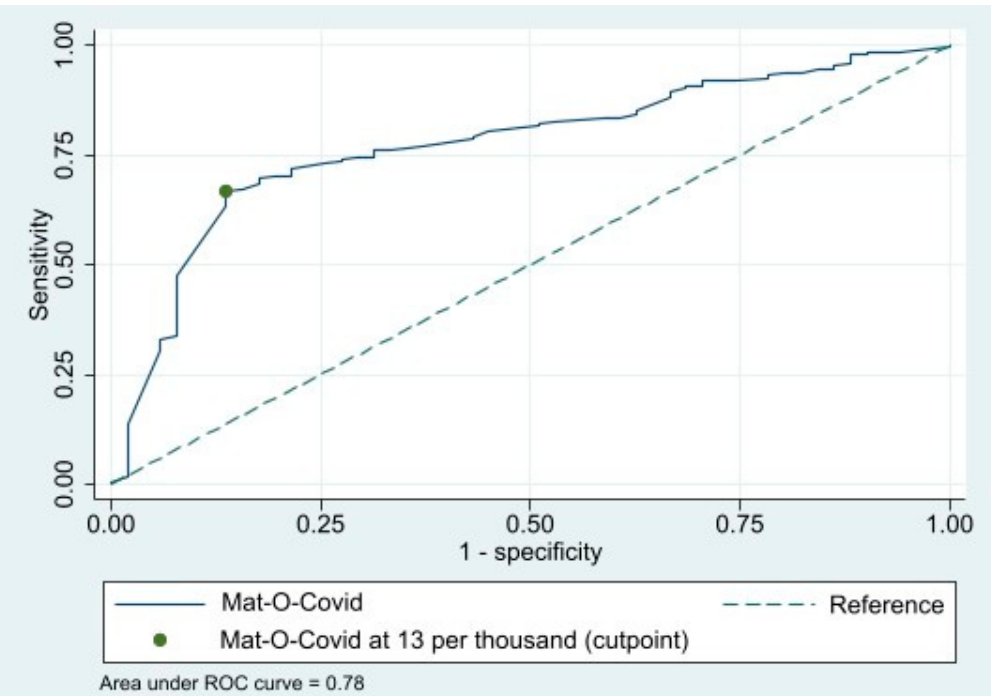
Figure 1. Receiver operative characteristic curve. Mat-O-Covid data were compared to the health insurance decisions on compensation. The Youden’s J statistic illustrated the cut point.